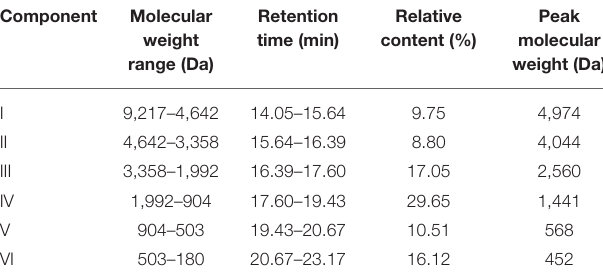
TABLE 2 | Molecular weight distribution of fish scale gelatin hydrolysate.